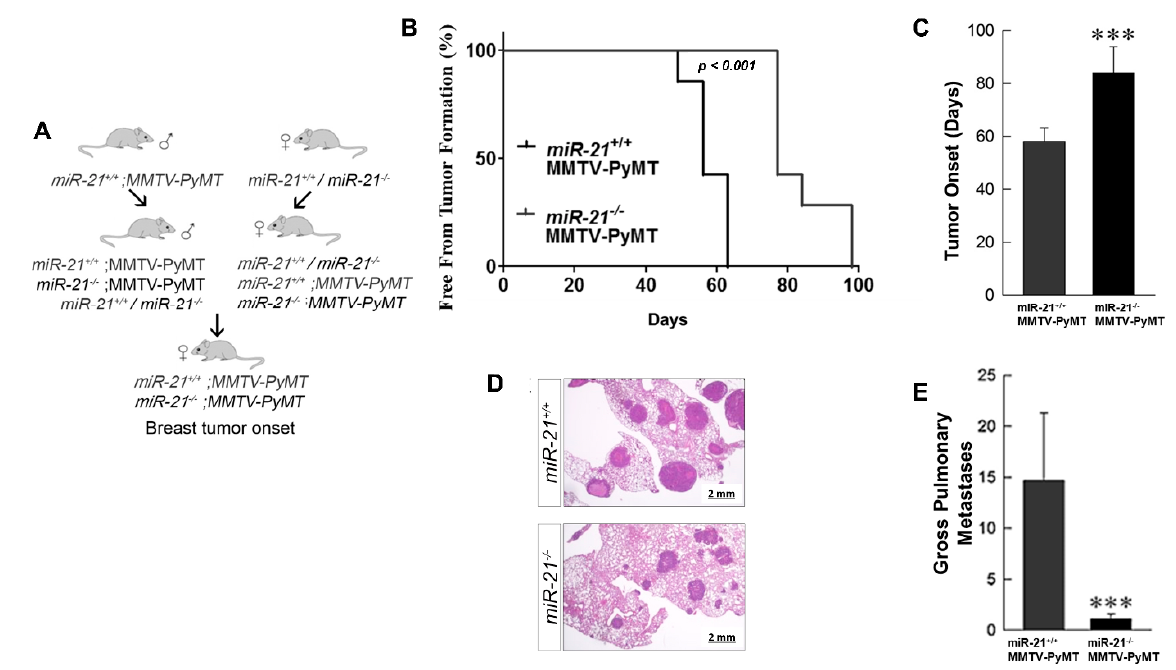
Figure 3. Genetic deletion of miR-21 delays tumor growth and reduces metastases in MMTV-PyMT mice. ( A ) Schema. ( B , C ) In crossing MMTV-PyMT mice with miR-21 +/+ and miR-21 − / − mice the miR-21 − / − ;MMTV-PyMT mice were noted to have a delay in tumor formation of 4 weeks compared with the miR-21 +/+ ; MMTV-PyMT mice, which was a statistically significant delay determined by Mantel–Cox test (3B) and student t -test (3C) (***- p < 0.001, n = 3 mice/group). ( D ) H&E staining of lung metastases in miR-21 +/+ ;MMTV-PyMT and miR-21 − / − ; MMTV-PyMT at 16 and 18 weeks after birth. ( E ) Total number of external lung metastases in the miR-21 +/+ and miR-21 − / − ; MMTV-PyMT mice. Tumor regrowth delay was determined using the Mantel–Cox test to generate a Kaplan–Meier curve. The overall tumor uptake ratio for the injected groups was compared among the groups and significance was determined using a pre-specified α = 0.025 (0.05/2).